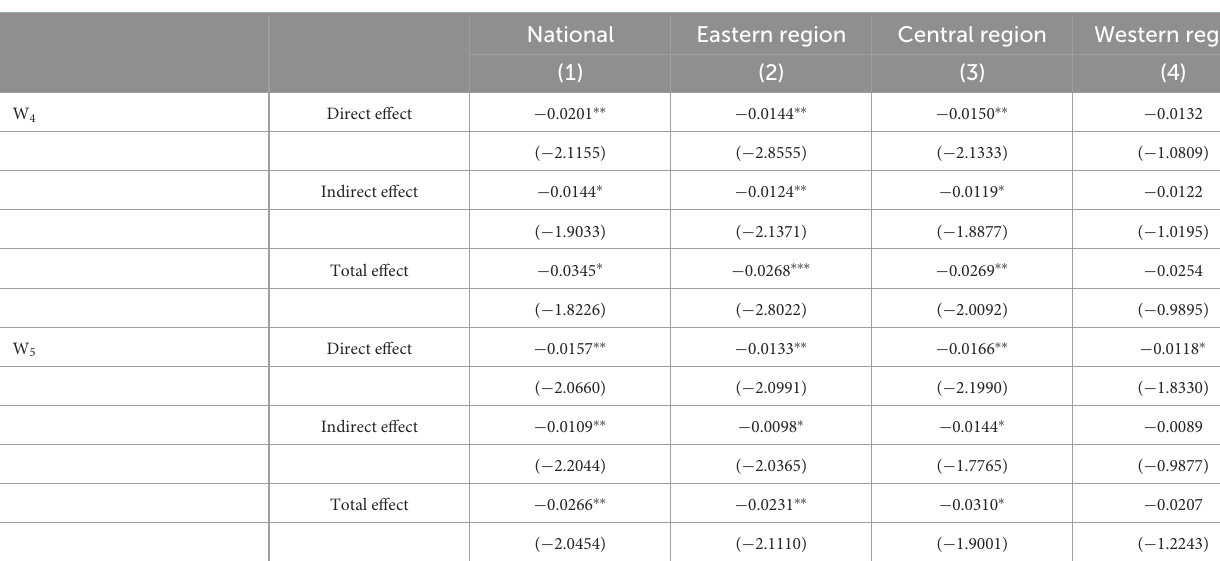
TABLE 8 Robustness test